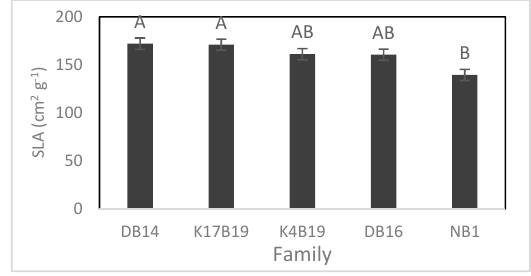
Figure 7. Variation of specific leaf area (SLA) of Senegalia senegal families. Different letters on bars mean significant differences among families at p < 0.05. Both SLA and root/shoot ratio were significantly reduced by the salt, decreasing from 169.7 to 152.2 cm 2 g − 1 and 0.61 to 0.47 in controls versus salt treated. The root/shoot ratio also decreased from 0.66 to 0.43 in controls versus fertilized plants.